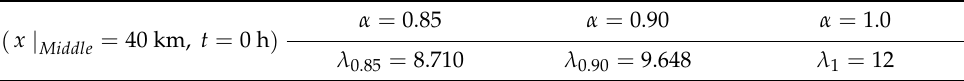
λ Table 1. Values of λ correspond to various values of α order. Table 1. Values of correspond to various values of α order . = 40 km, t = 0 h ) ( x | Middle